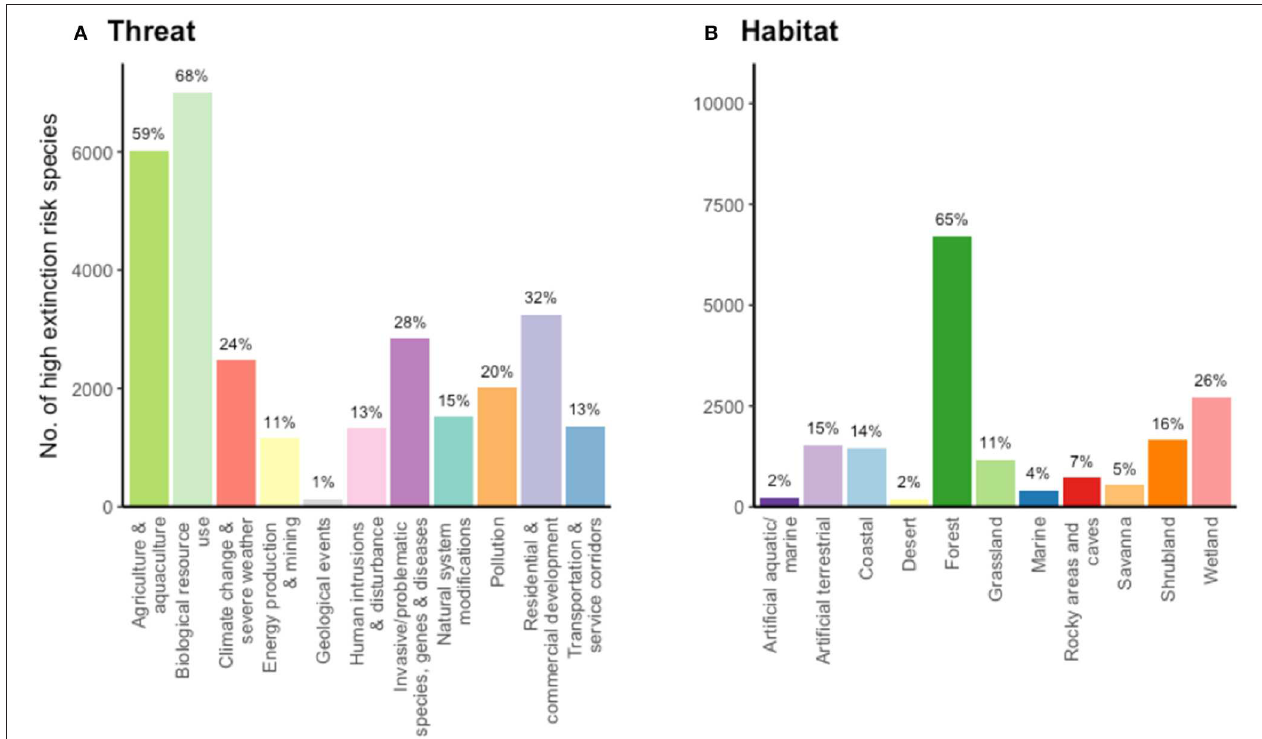
FIGURE 1 | The number of high extinction risk species in each Red List Threat and Habitat class. Percentages on bars refer to the percentage of high extinction risk comprehensively assessed taxa that occupy the habitat (B) or are exposed to the threat (A) . Data are from Red List version 2017.3 (see Table S1 ). High extinction risk refers to species in six of the eight Red List categories; Near Threatened (NT), Vulnerable (VU), Endangered (EN), Critically Endangered (CR), Extinct in the Wild (EW), Extinct (EX). Least Concern (LC), and Data Deficient (DD) are the remaining two categories. To date 35,306 of the > 91,000 Red List species have been comprehensively assessed, and of these 10,249 are classed as high extinction